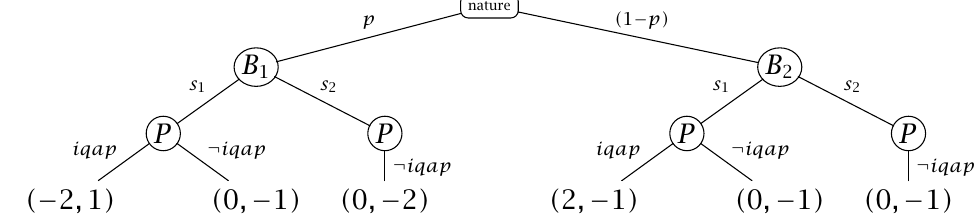
P ’s model of the game where B responds to ( 1 c) and P interprets that response. B is a type of Bronston that likes to misdirect P , 1 while B prefers not to misdirect P . The utilities are in the order 2 (P, B)